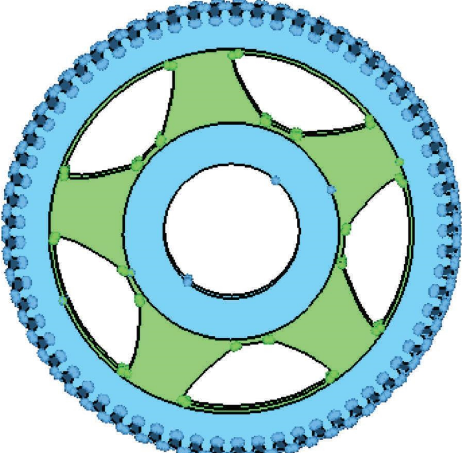
Figure 15: Schematic diagram of the improved gear structure.